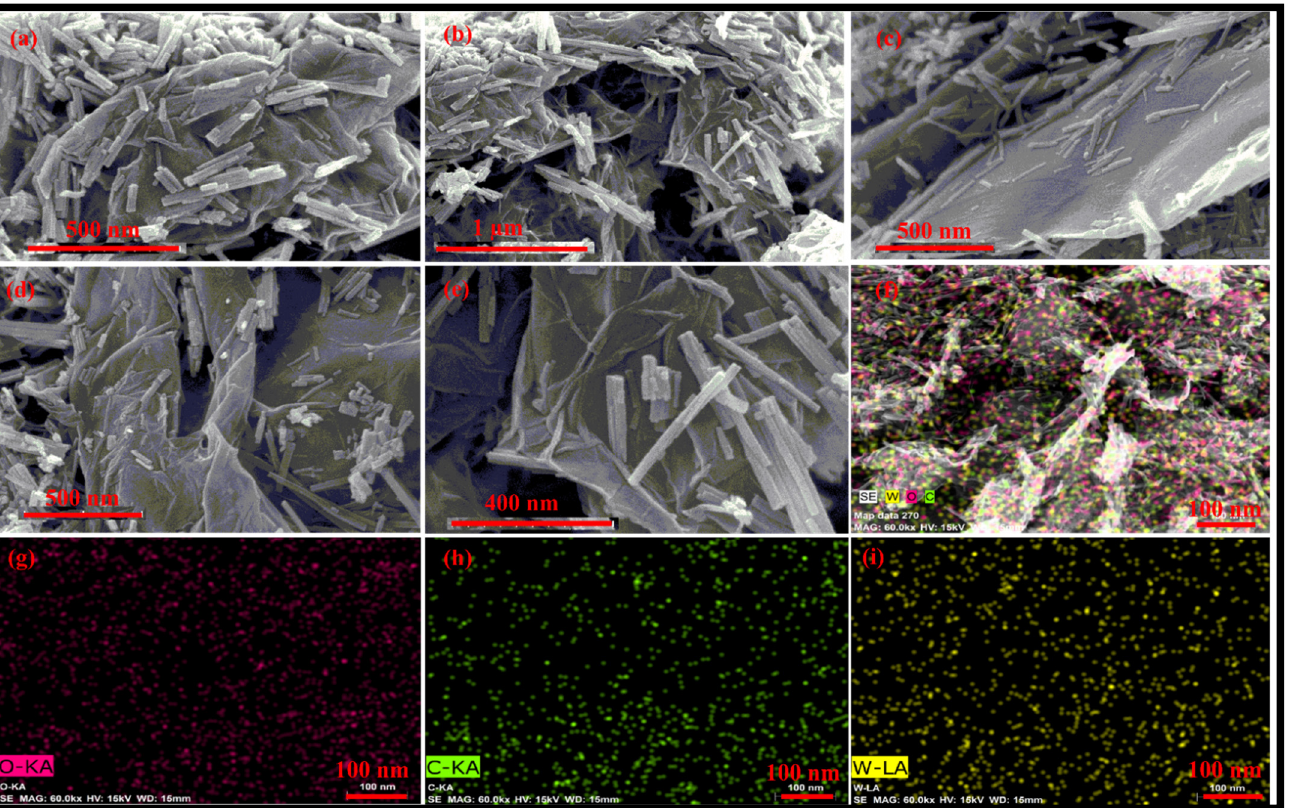
Figure 3. Typical ( a – e ) FESEM micrographs of the prepared rGO-WO 3 heterostructure and elemental mapping images of ( f ) the rGO-WO 3 heterostructure, ( g ) W, ( h ) O and ( i ) C elements.